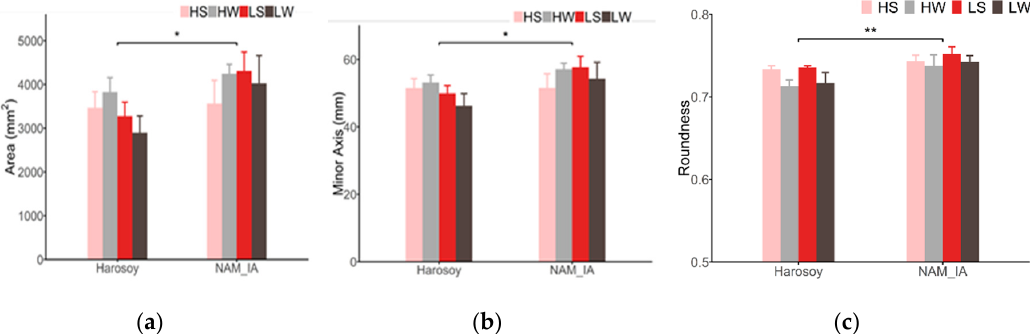
Figure 11. Leaf morphological features’ difference between groups by LeafScope. ( a ) Leaf area (P < 0.05 for genotype, P = 0.7477 for water, P = 0.6284 for N by three-way ANOVA); ( b ) Leaf minor axis length (P < 0.05 for genotype, P = 0.9747 for water, P = 0.5925 for N by three-way ANOVA); ( c ) Leaf roundness (P < 0.01 for genotype, P = 0.4251 for N, P < 0.05 for water, by three-way ANOVA). Data are represented as mean ±SE (n = 5). *P < 0.05, **P < 0.01 for genotype effect by three-way ANOVA. HS, high N and drought-stressed; HW, high N and well-watered; LS, low N and drought-stressed; LW, low N and